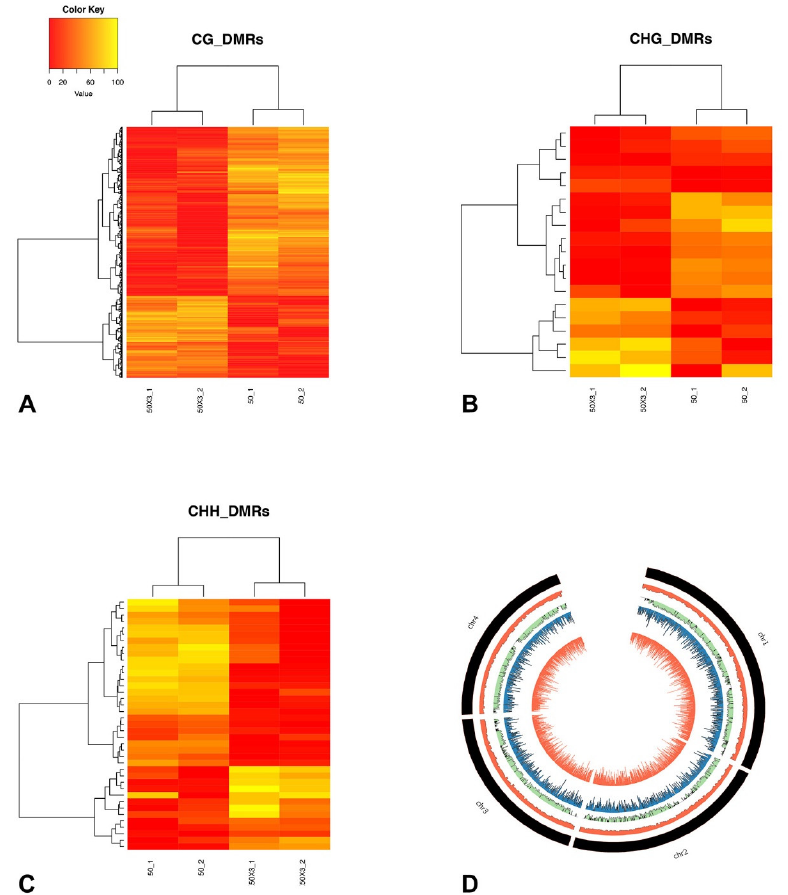
Figure 4. Relative methylation frequencies of differentially methylated regions as identified from the comparison between SC50 and SC50 × 3 subcultures. Relative methylation frequencies of the differentially methylated positions contained in each differentially methylated region ( A – C ) for CG, CHG, and CHH, respectively) were averaged and used in complete linkage clustering analysis of samples derived from SC50 and SC50 × 3 based on differentially methylated regions. ( D ) Circos plot. From outer inward: number of genes in adjacent genomic chromosome regions of 20 kb. Ratio of the number of F. graminearum-F. verticillioides collinear genes and total number of F. graminearum genes in each region. DMPs (CG context) and DMRs (CG